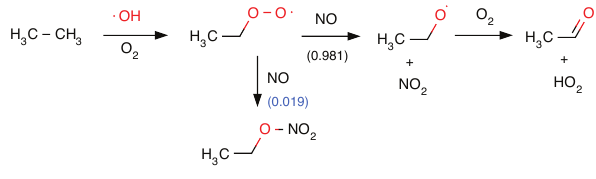
Figure B1. Ethane oxidation by OH radical in the presence of